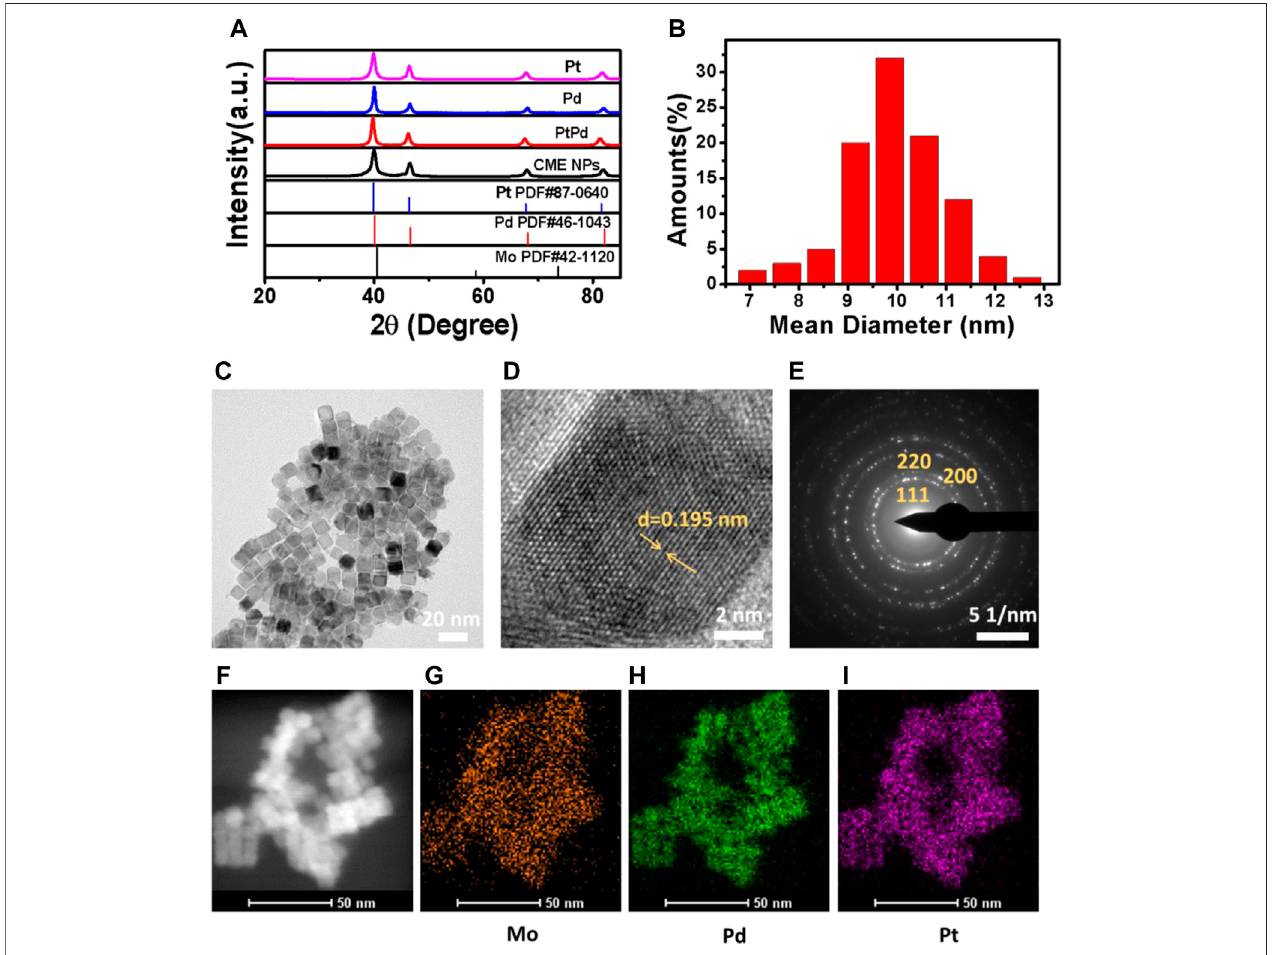
FIGURE1| XRD (A) ,sizestatistical analysisspectra (B) , TEM (C) ,HRTEM (D) ,SAED (E) ,and TEMEDX mapping( Figures1F – I ) ofthe synthesizednanoparticles.